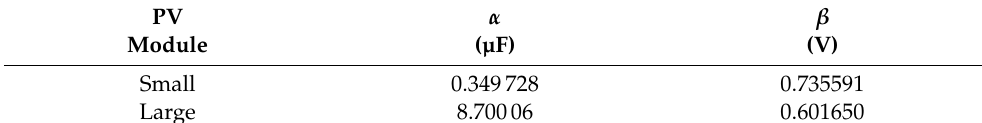
Table 7. Capacitance modelling parameters for the two PV modules.